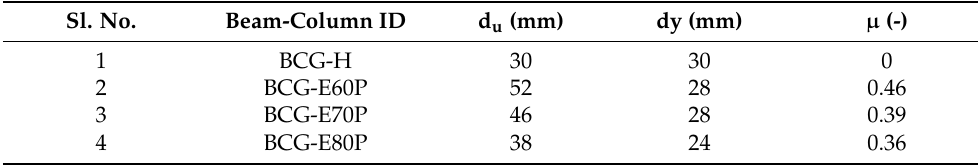
Table 8. Pseudo-ductility index for all beam-column